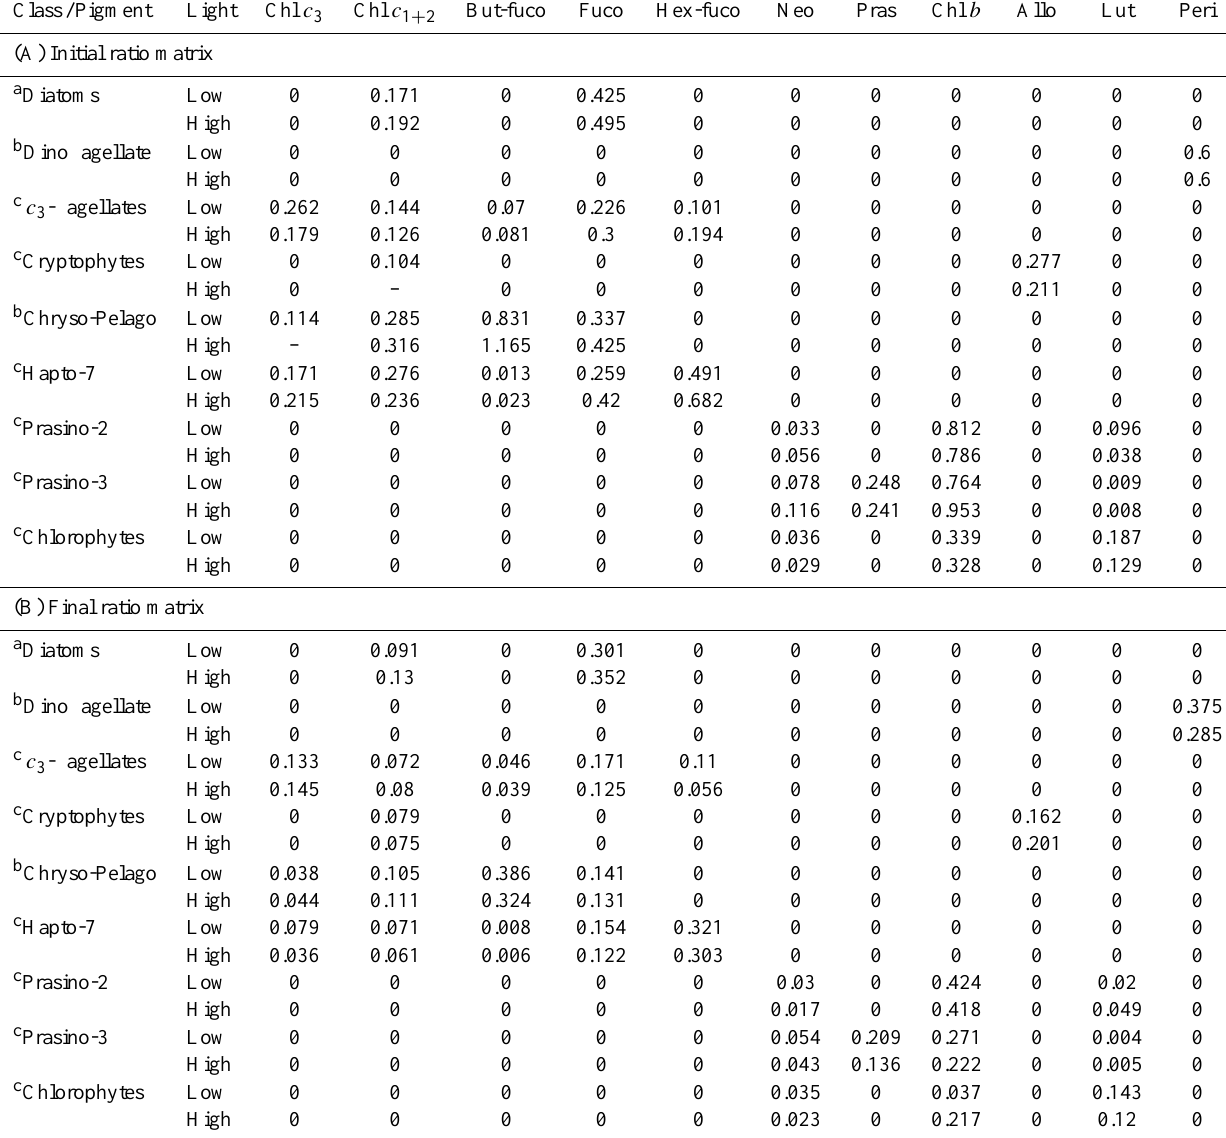
Table 3. Pigment:TChl a ratios for each algal group under low (SCM samples) and high light (surface samples) light levels. (A) Initial ratio matrix determined from a this study, b Vidussi et al. (2004), c Higgins et al. (2011); (B) final ratio matrix obtained after CHEMTAX recalculation in order to find the best fit between the in situ pigment concentrations and our initial ratio matrix. The symbol “–” indicates similar ratios between low and high light levels. Pigment abbreviations are defined in Table 1. According to Higgins et al. (2011): Chryso- Pelago: Chrysophytes and Pelagophytes; Hapto-7: haptophytes type 7; Prasino-3: prasinophytes type 3; Prasino-2: prasinophytes type